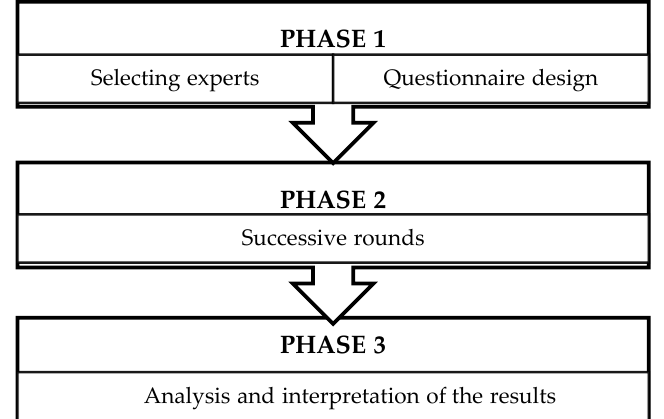
Figure 1. Delphi Technique: phases and procedure.